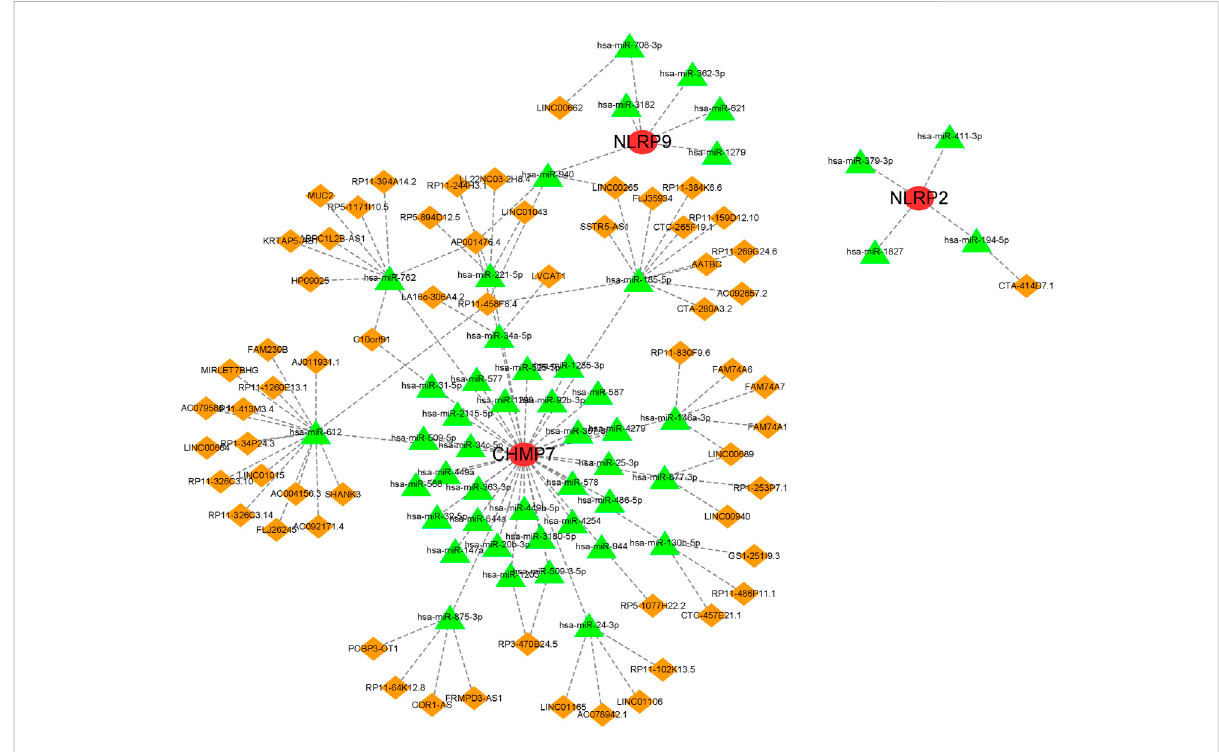
FIGURE 8 A ceRNA network based on marker